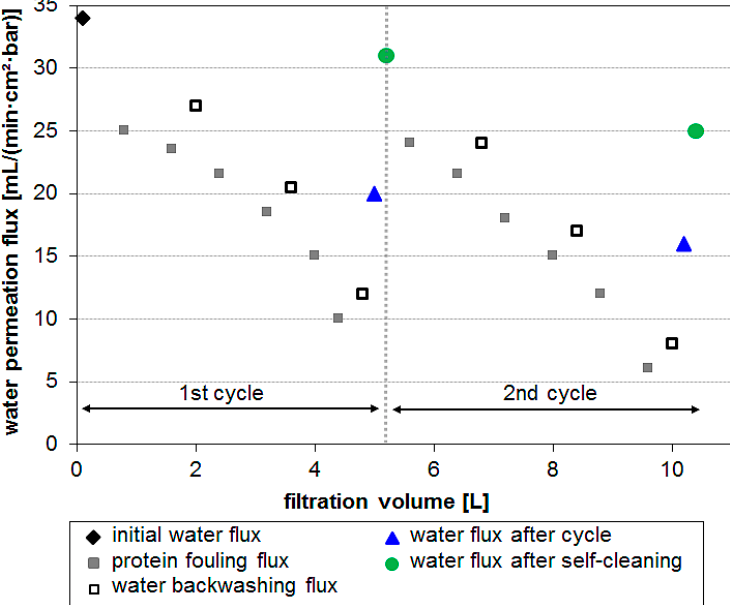
Figure 3. General fouling experiment procedure.